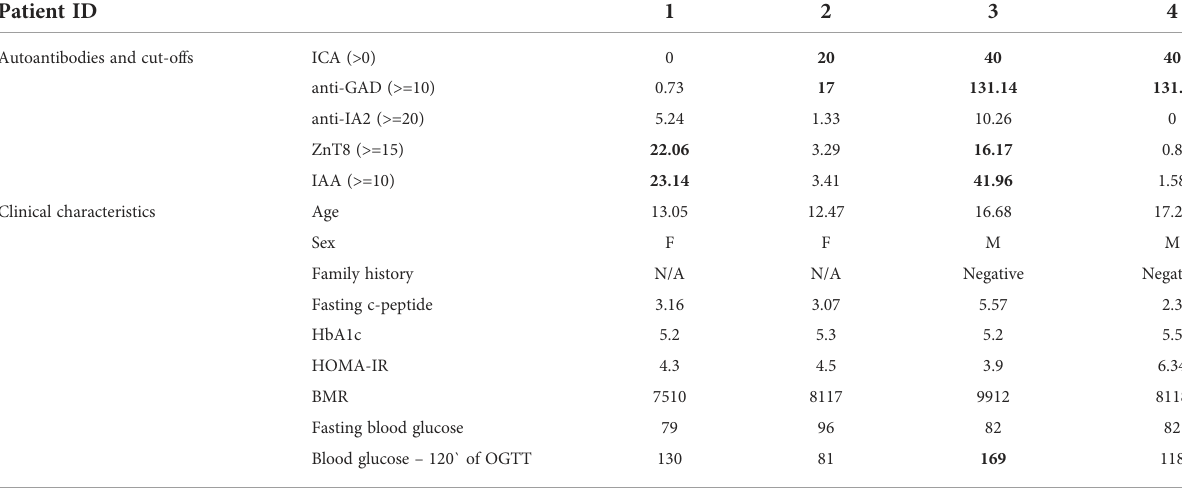
(ICA, antibodies against cytoplasmic antigens of pancreatic islets; GAD, antibodies against glutamic acid decarboxylase; ZnT8, antibodies against zinc transporter; IA2, antibodies against tyrosine phosphatase; IAA, anti-insulin antibodies; HOMA-IR- Homeostatic Model Assessment – Insulin Resistance; BMR-basal metabolic